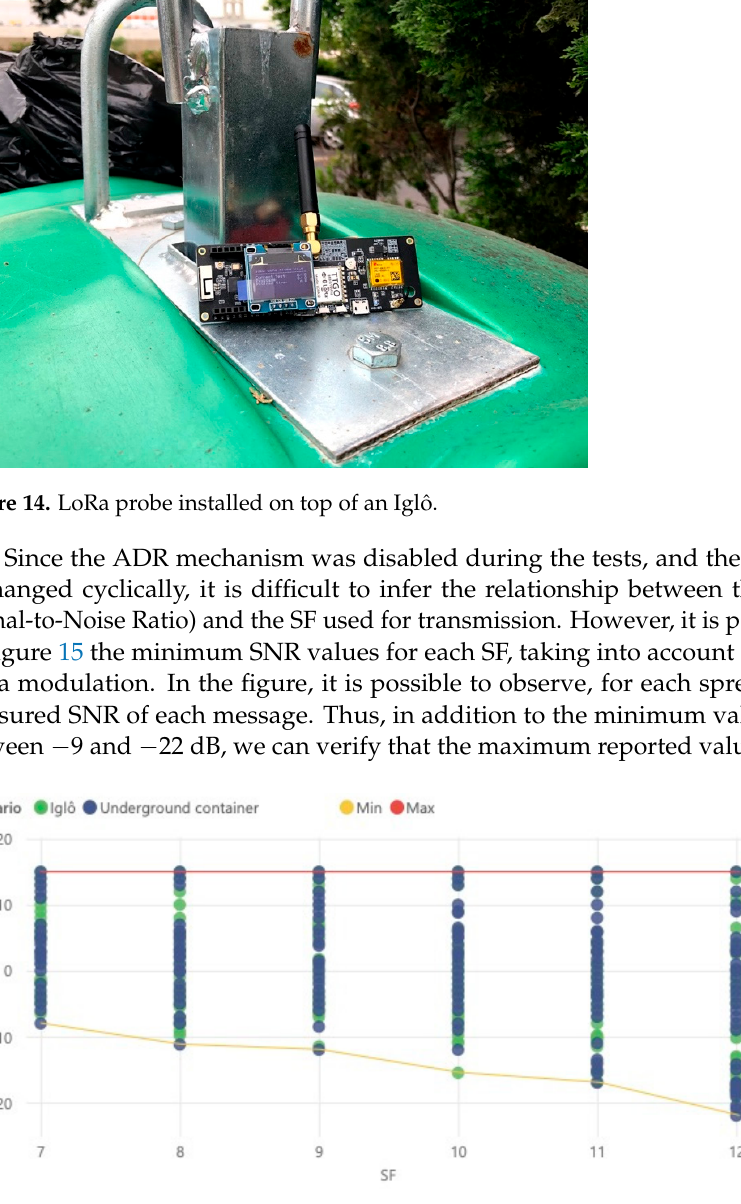
Figure 15. Received message SNR versus spreading factor.